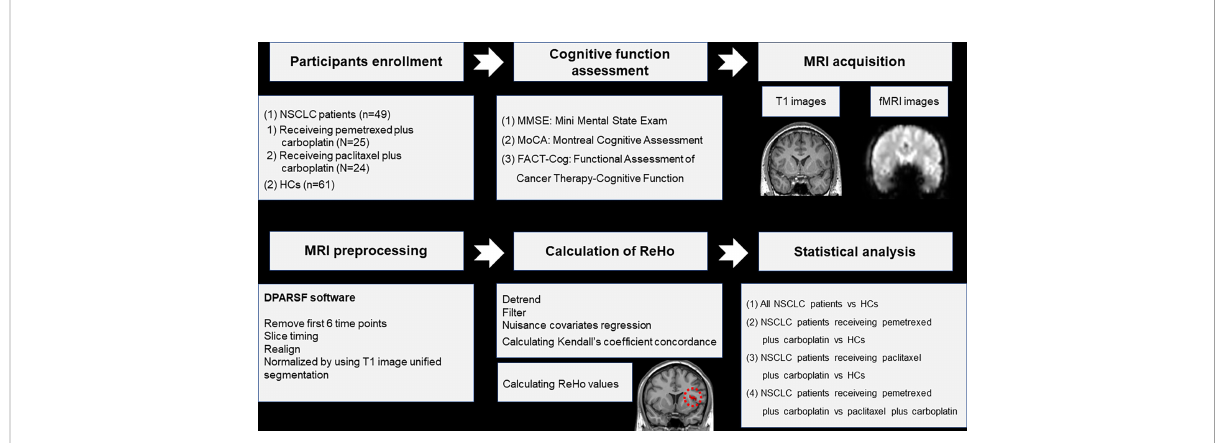
FIGURE 1 Schematic overview of the study. NSCLC: non-small cell lung cancer; HCs: healthy controls. ReHo: regional homogeneity. fMRI: functional magnetic resonance; DPARSF: data processing assistant for